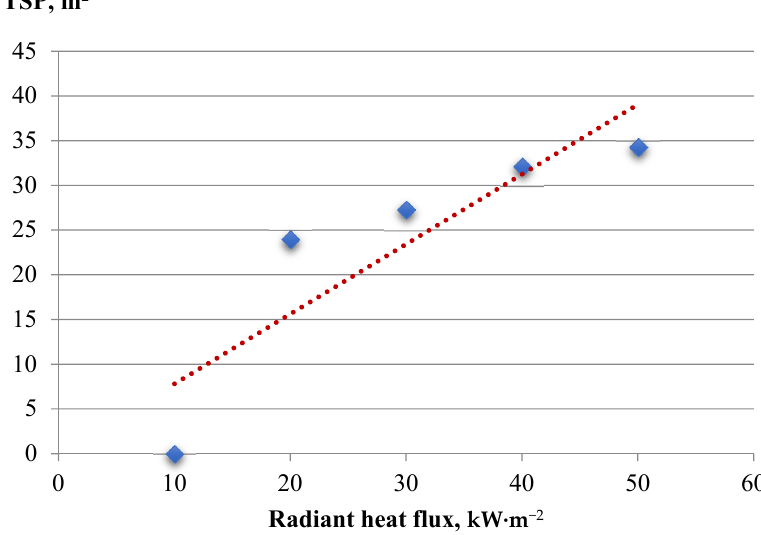
Figure 6. Total smoke production (TSP) as a function of radiant heat flux for a PVC coaxial power cable.